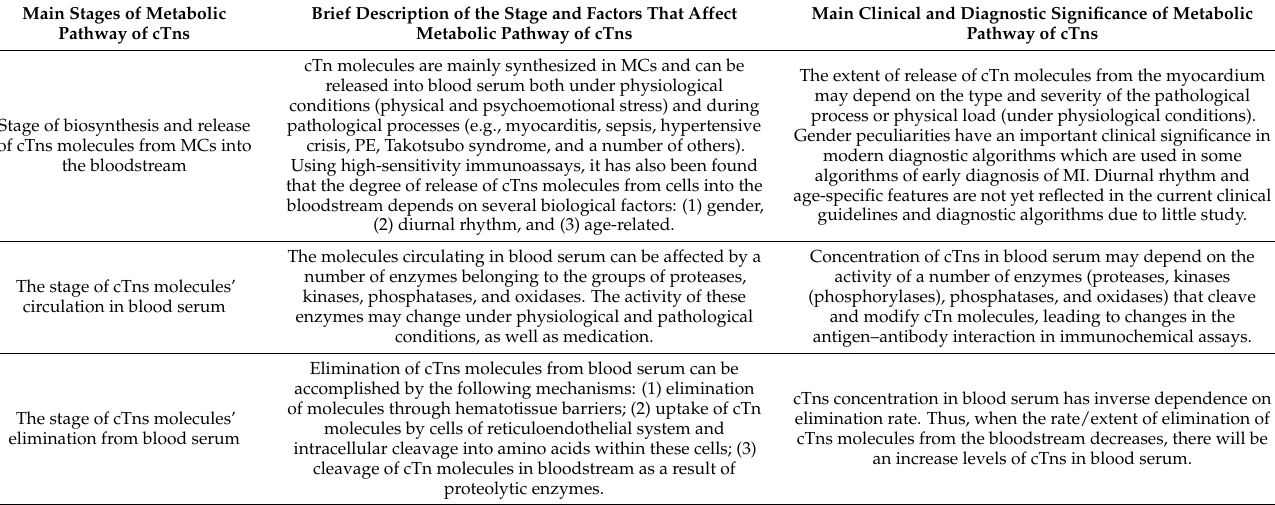
Table 1. Metabolic pathway of